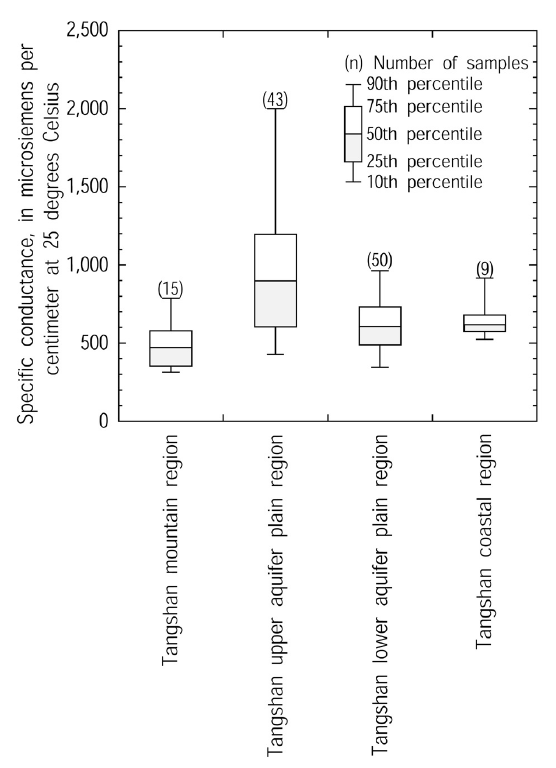
FIGURE 6. Boxplots of specific conductance for wells in various physiographic regions of the Tangshan study